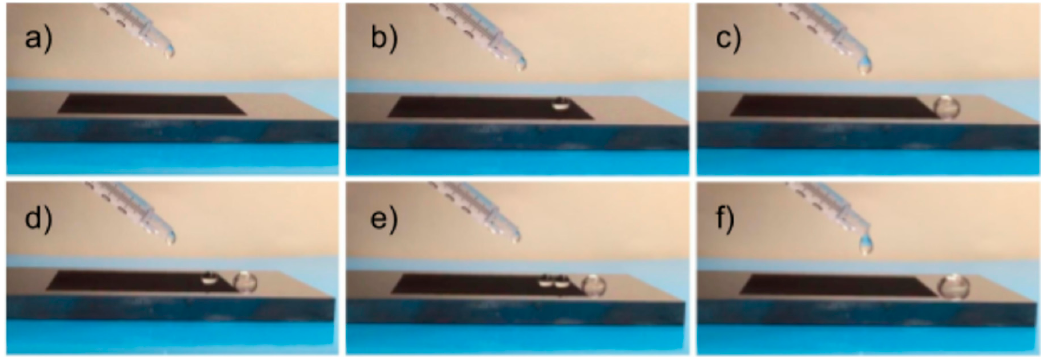
Figure 7. A series of frames of water droplets bouncing o ff a hydrophobic metal surface fabricated by fs fiber lasers over a time interval of 7 s. ( a ) Water droplet exits the needle. ( b ) First water droplet makes contact with metal. ( c ) First water droplet rolls o ff the hydrophobic region of the metal. ( d ) Second water droplet drops on the metal surface. ( e ) A third water droplet makes contact with the second water droplet still on the hydrophobic region of the metal. ( f ) The second and third water droplets roll o ff the processed area and merge with the first water droplet.